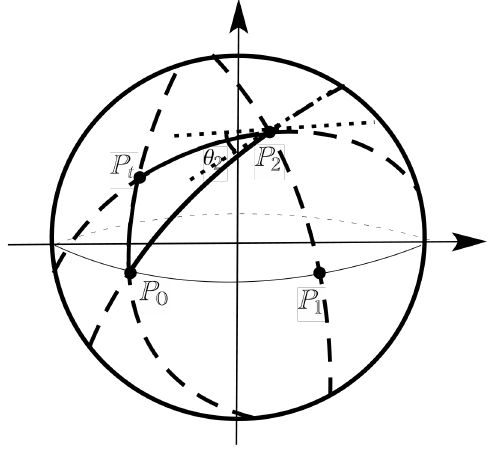
Figure 6. Distance travelled on the sphere after the k -th Poisson